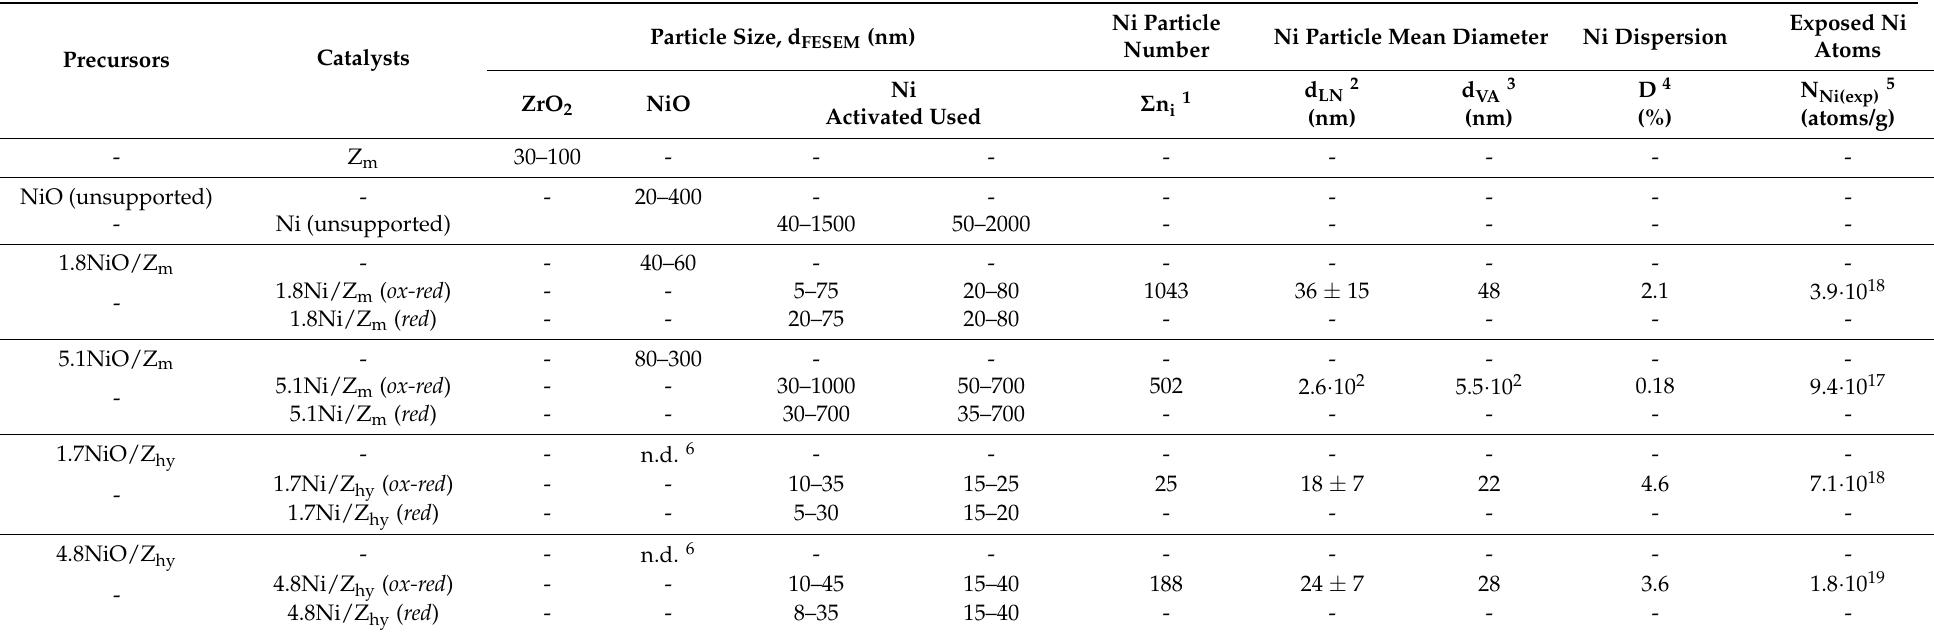
Table 2. FESEM images analysis for Z m , NiO and